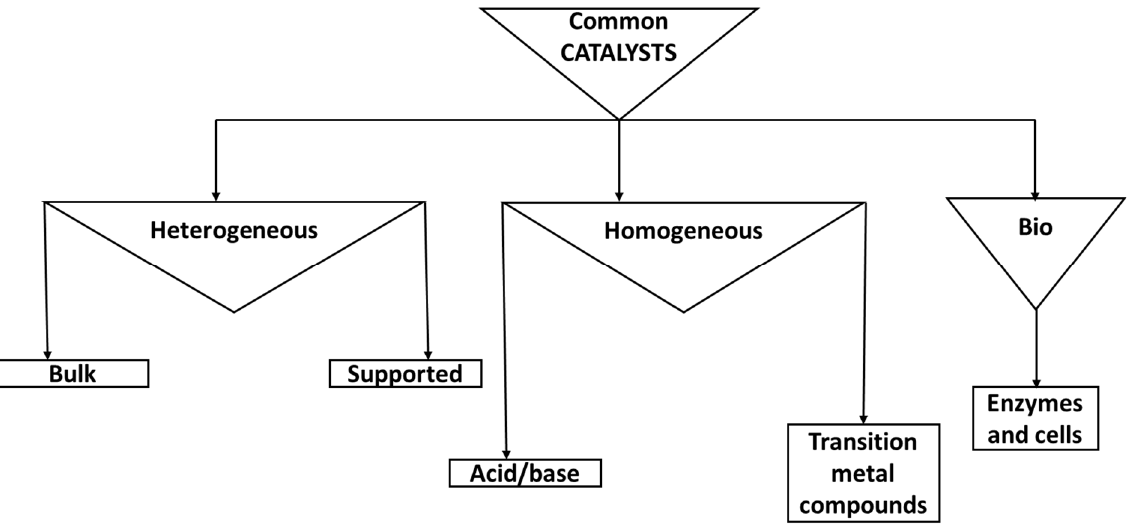
Figure 2. Common catalyst types with emphasis on heterogeneous and homogeneous catalysts.